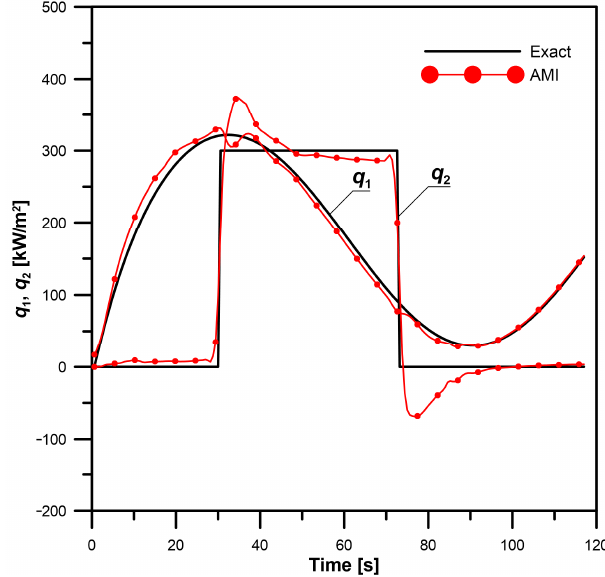
Figure 16. Comparison between exact heat fluxes and those calculated by the AMI method for an irregular plate.